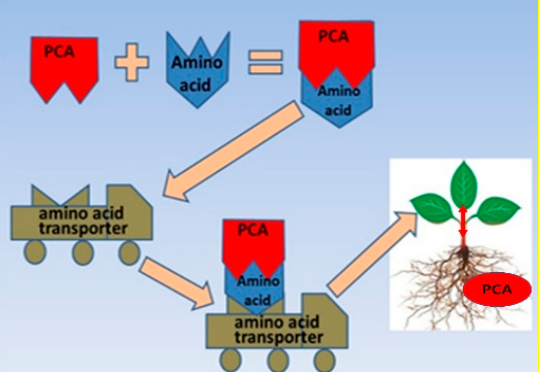
Figure 4. Translocation mechanisms of PCA-amino acid conjugates involved in an amino acid transporter (Reference from [23]).